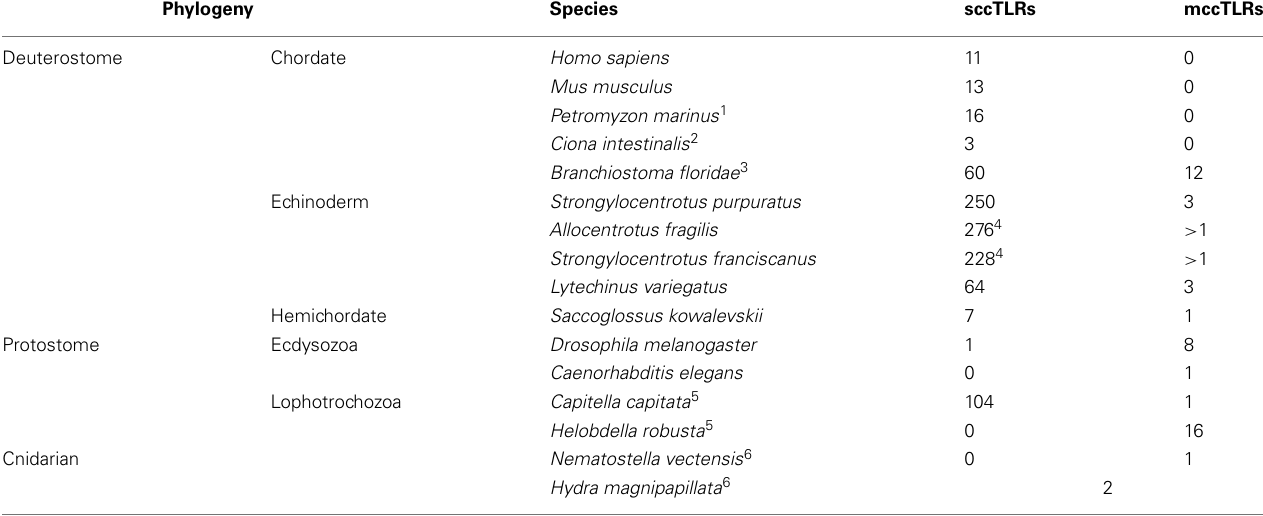
Table 1 | Sizes ofTLR gene family vary among